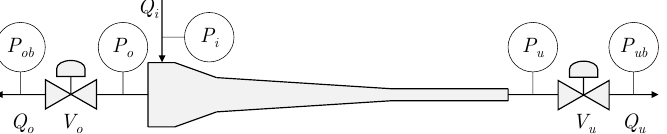
Figure 3. Common instrumentation associated with a single hydrocyclone liner, where P ob and P ub is the back pressure at overflow and underflow,